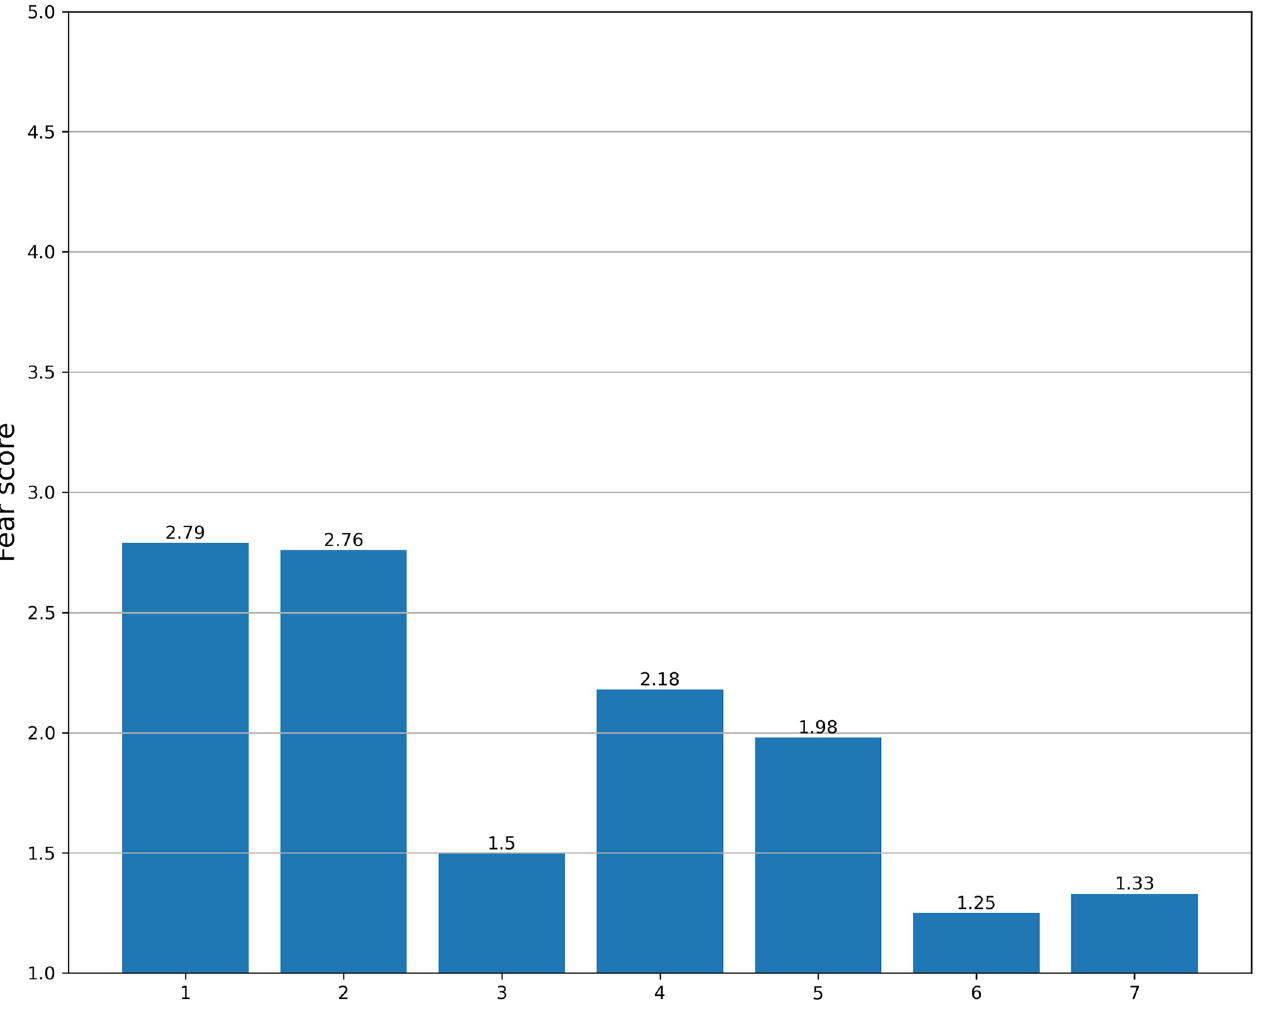
Fig 2. Mean score of fear for the seven questions in the fear of Covid 19 scale in the whole study